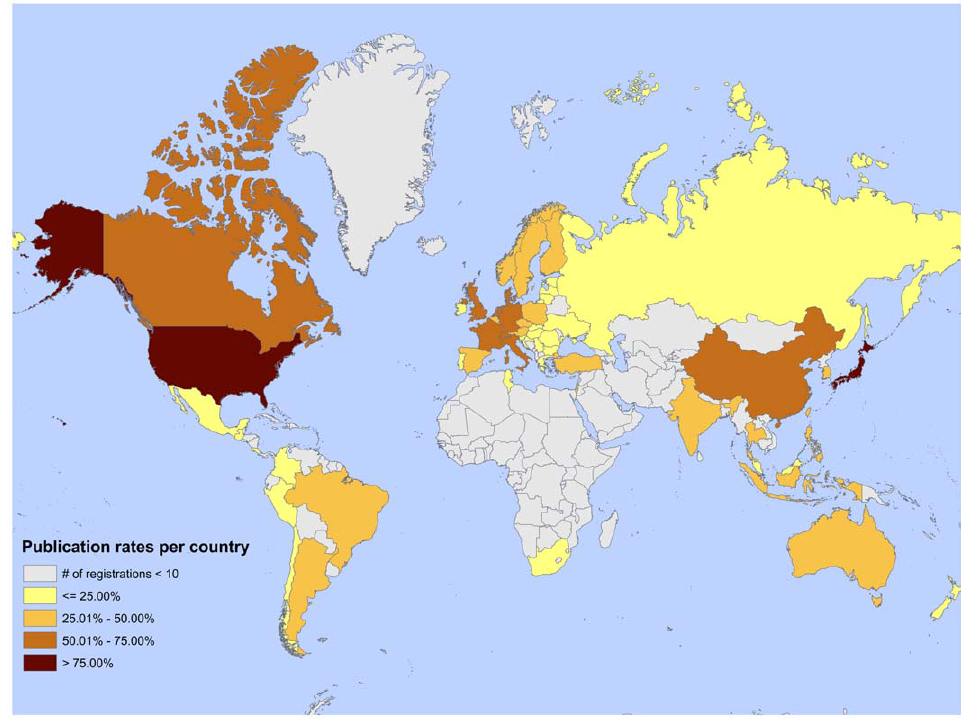
Figure 2. Authorship rates per country for all registrations (n=1,445).